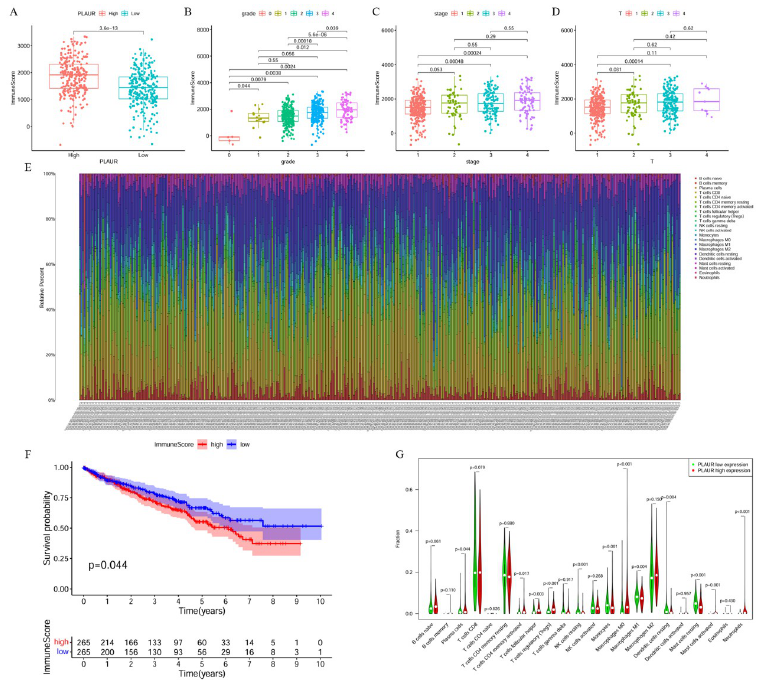
Fig 6. Correlation analysis between PLAUR expression and immune cell infiltration. A. Correlation between high and low PLAUR expression and ImmuneScore; B. Correlation between Grade and ImmuneScore; C. Correlation between Stage and ImmuneScore; D. Correlation between T stage and ImmuneScore; E. Immune cell infiltration level stacking graph; F. Correlation between ImmuneScore and ccRCC patient prognosis correlation analysis; G. Immune cell infiltration level and PLAUR expression correlation